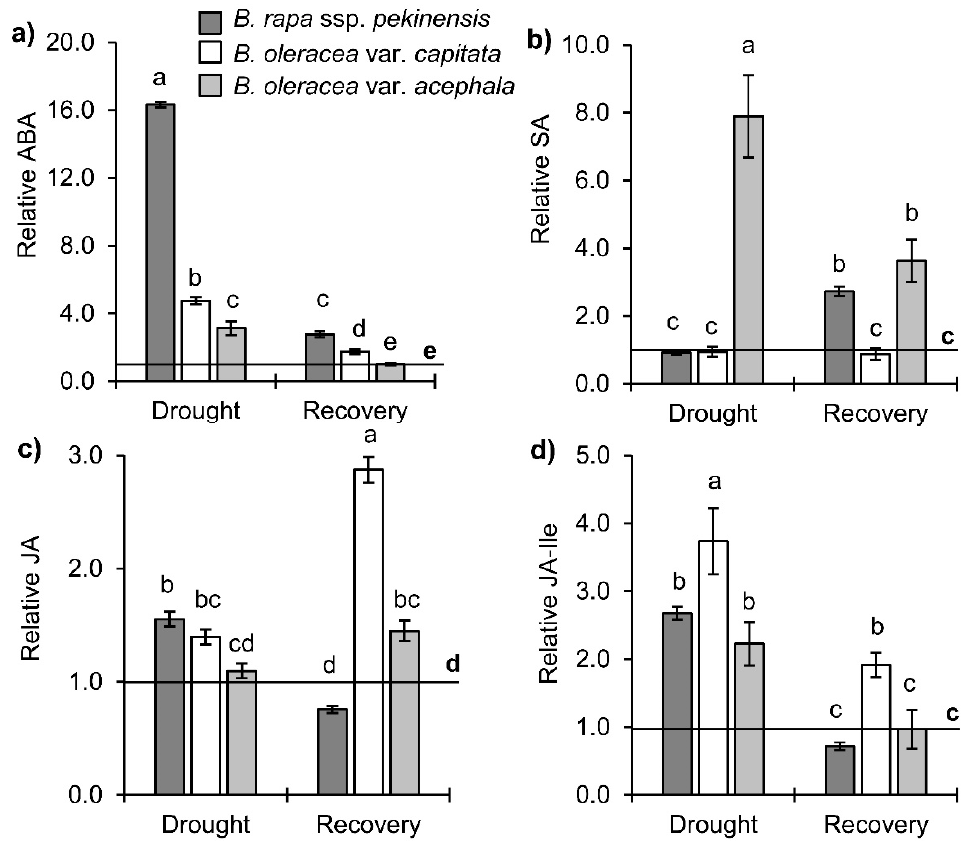
Figure 5. Stress hormones profile in Brassica crops under drought and recovery: ( a ) ABA, ( b ) SA and jasmonates ( c ) JA and ( d ) JA-Ile. Controls are normalized to the value 1. Columns marked with different letters are statistically significantly different ( p ≤ 0.05). Data are mean ± SD, n = 4. Raw data are presented in Supplementary Table S4.